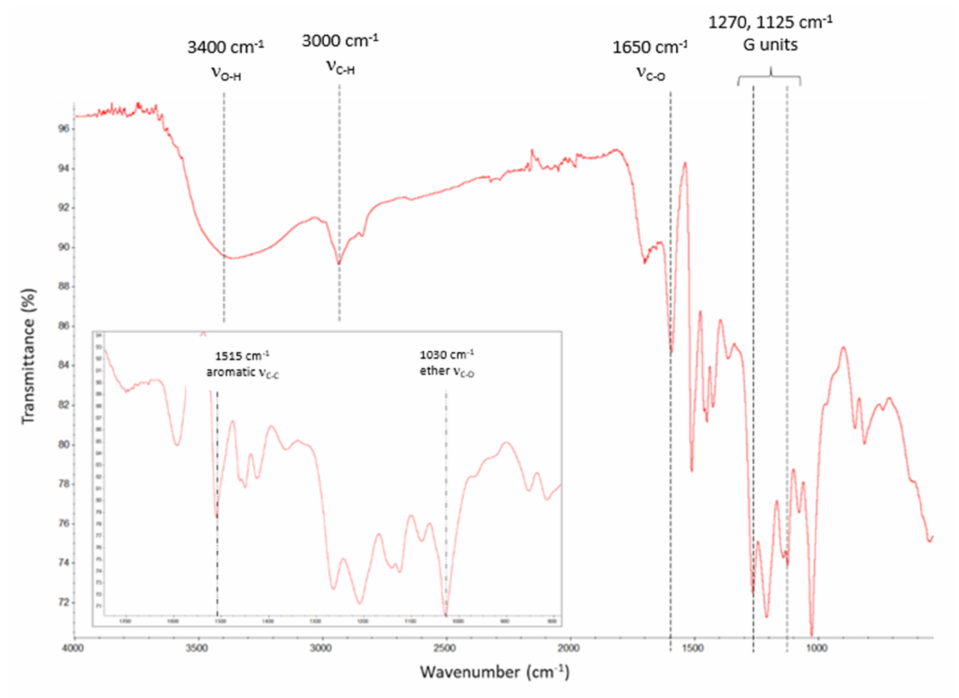
Figure 7. FTIR-ATR spectrum of Kraft lignin reactant.